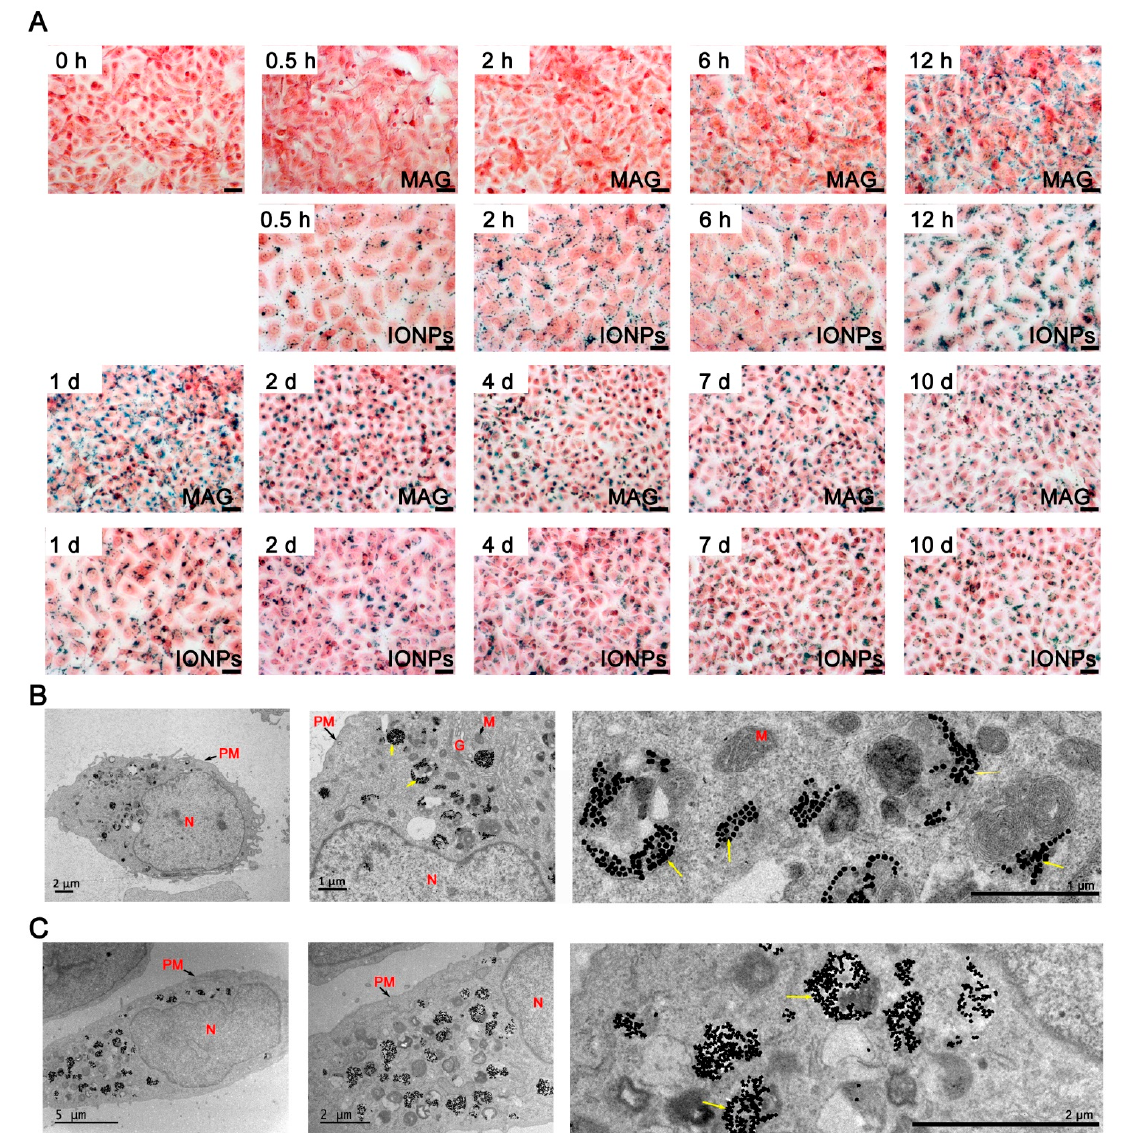
Figure 3. The cellular internalization of nanoparticles in ECs. ( A ) Optical microscopy Prussian blue stained images showing the internalization of MAGs and IONPs by ECs at different timepoints. ECs were treated with MAGs or IONPs at 10 μ g Fe/mL. The blue dots representing the Fe and the cells were stained by eosin staining. Scale bar, 20 μ m. ( B ) TEM image of MAGs (yellow arrows) within vesicle-like structures in the cytoplasmic region of ECs after 48 h incubation (10 μ g Fe/mL). ( C ) TEM image of IONPs (yellow arrows) within vesicle-like structures in the cytoplasmic region of ECs after 48 h incubation (10 μ g Fe/mL). Abbreviations: PM, plasma membrane; N, nucleus; M, mitochondria; G, Golgi apparatus.